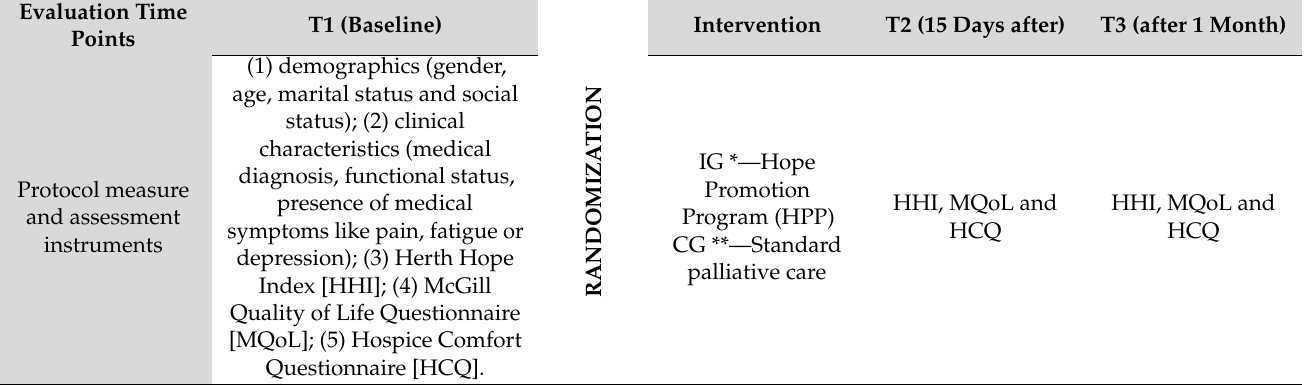
Table 1. Investigation